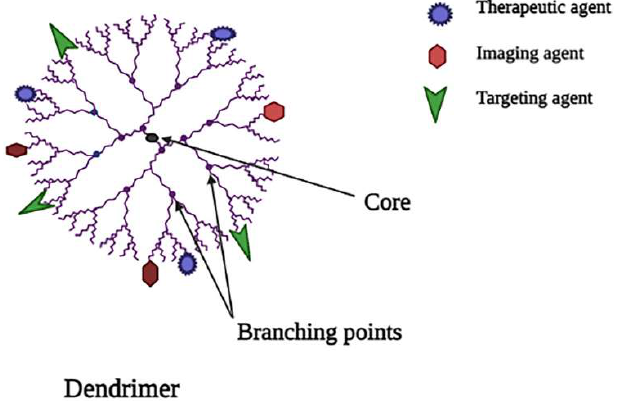
Figure 3. Schematic representation of dendrimer.